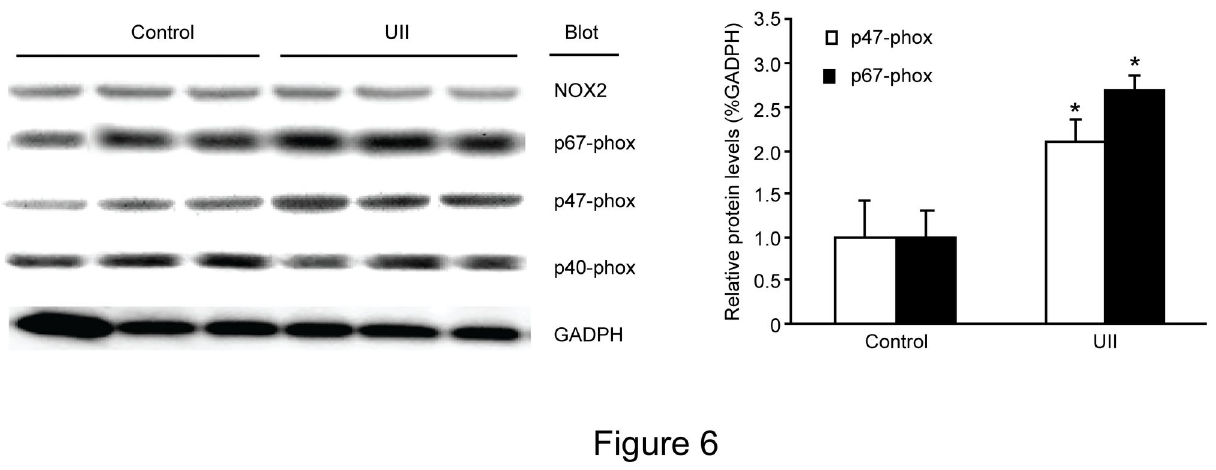
Figure 6. Effect of UII on NADPH oxidase subunit expression. C2C12 cells were stimulated with 100 nM UII for 2h after treatment with apocynin for 30 minutes. Western blot analysis was performed with antibodies against NOX2, p67-phox, p47-phox, p40 phox and p22 phox . Equal loading was confirmed by reprobing the membranes with GAPDH antibody. Control: cells were incubated with fresh FCS free DMEM for 24h; UII: cells were treated with UII (100 nmol/L) for 24h. Data are presented as the relative increase compared with control (100%; n=3, * P <0.05 vs group; # P <0.05 vs UII